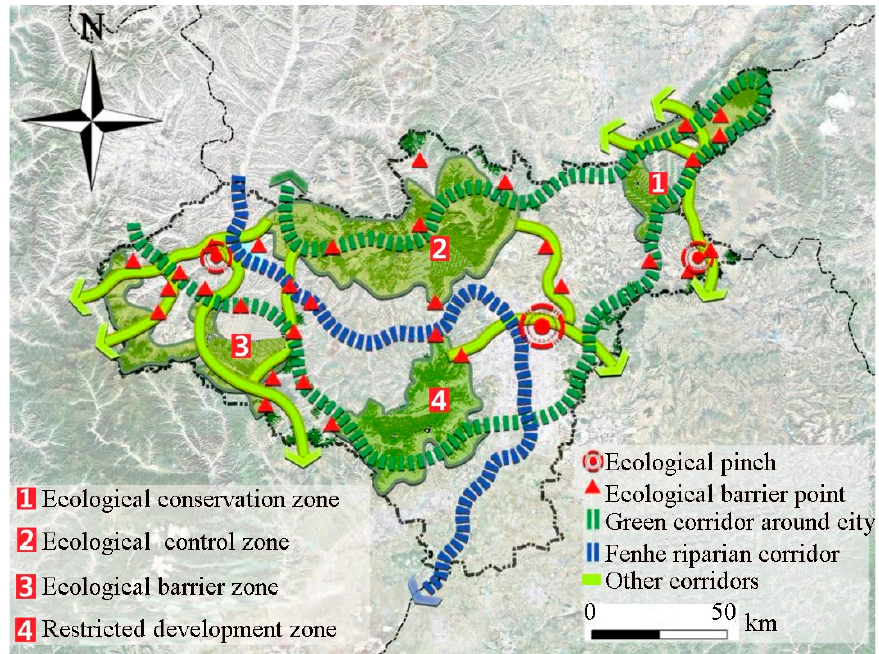
Figure 10. Optimization model of ecological security pattern in Taiyuan City.